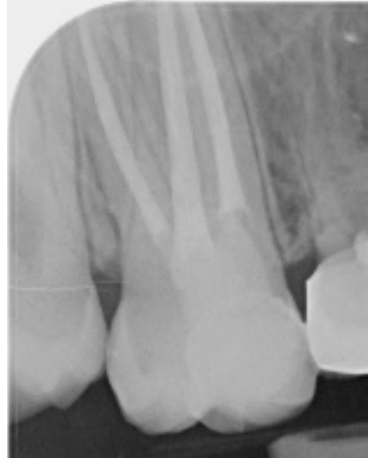
Figure 8. Final X-ray demonstrating marginal integrity and correct fit of the restoration.